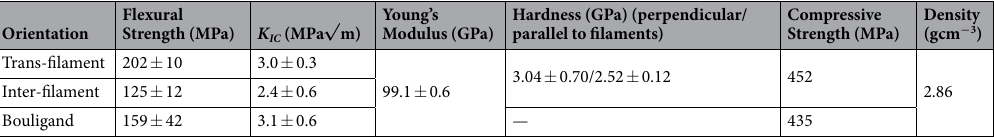
Table 1. Bulk mechanical properties of each composite